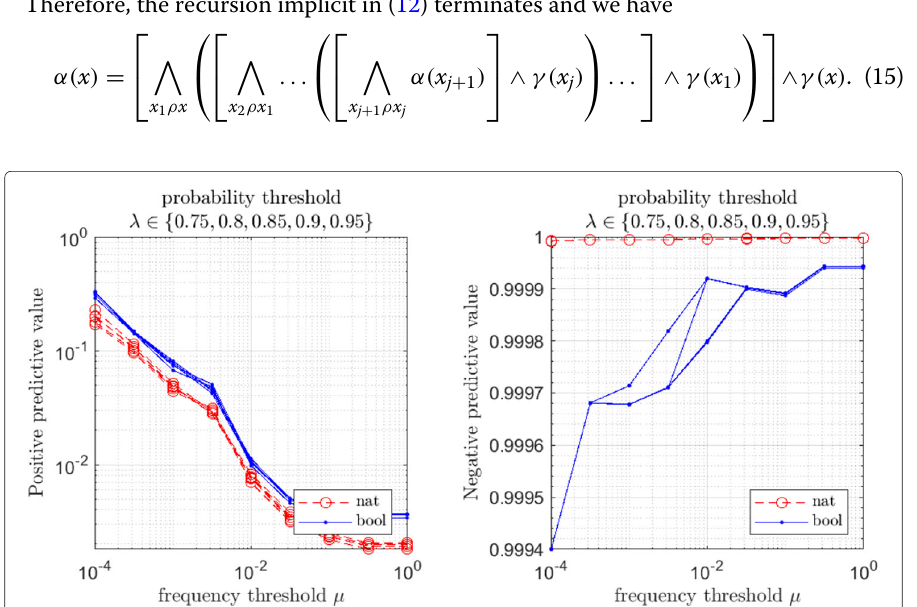
Fig. 4 Positive (left) and negative (right) predictive values as defined in (11) for APT detections using the model of “Markov chain models for DCNs” section and as functions of a per-window frequency threshold μ and for varying flow probability thresholds